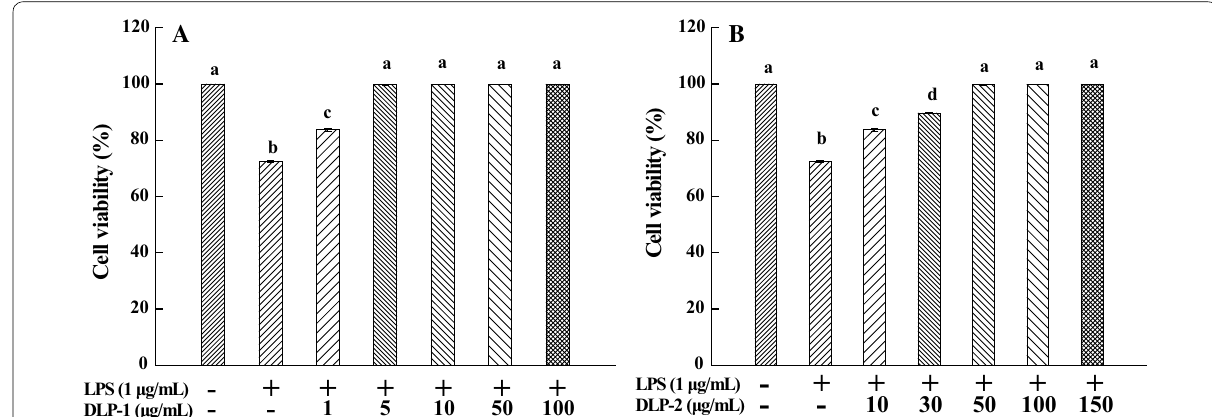
Fig. 2 Effects of DLP-1 and DLP-2 on cell viability. A Cells were treated with LPS (1 μg/mL) for 24 h in the absence or presence of DLP-1 at different concentrations (1, 5, 10, 50 and 100 μg/mL). B Cells were treated with LPS (1 μg/mL) for 24 h in the absence or presence of DLP-2 at different concentrations (10, 30, 50, 100 and 150 μg/mL). Cell viability was measured using MTT assay. Values were mean letter were not significantly different between groups at P < 0.05, in accordance with Duncan’s multiple range test